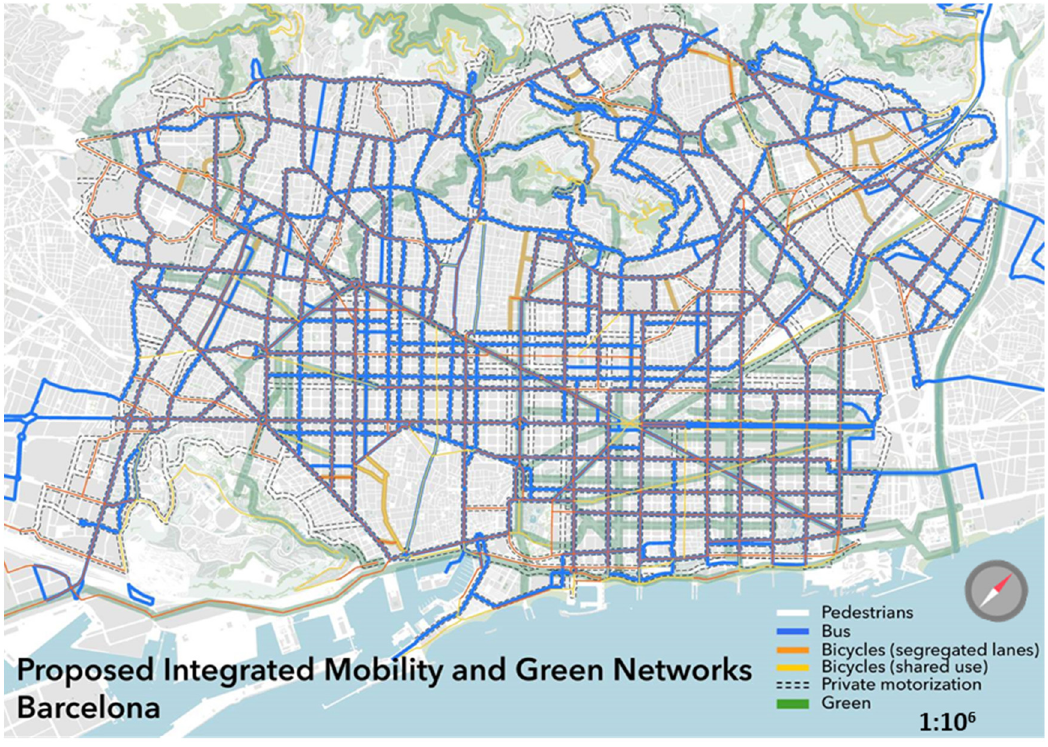
Figure 3. Proposed Integrated Mobility and Green Networks. Barcelona. Source: Reproduced from [30].